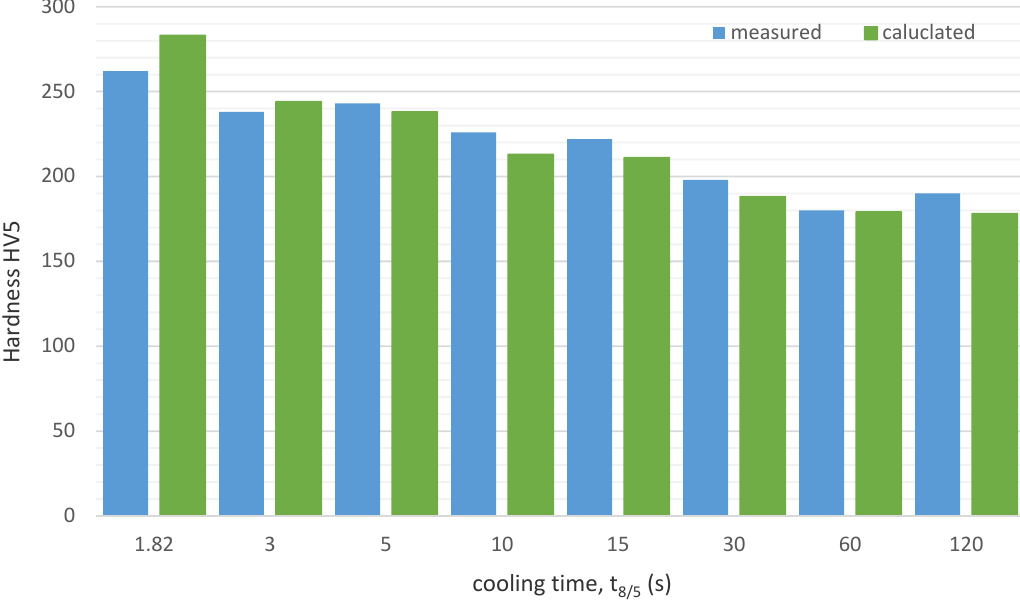
Figure 19. The comparison of the real and calculated results of hardness measurements in the thermo-mechanically and numerical simulated HAZ areas of S700MC steel.